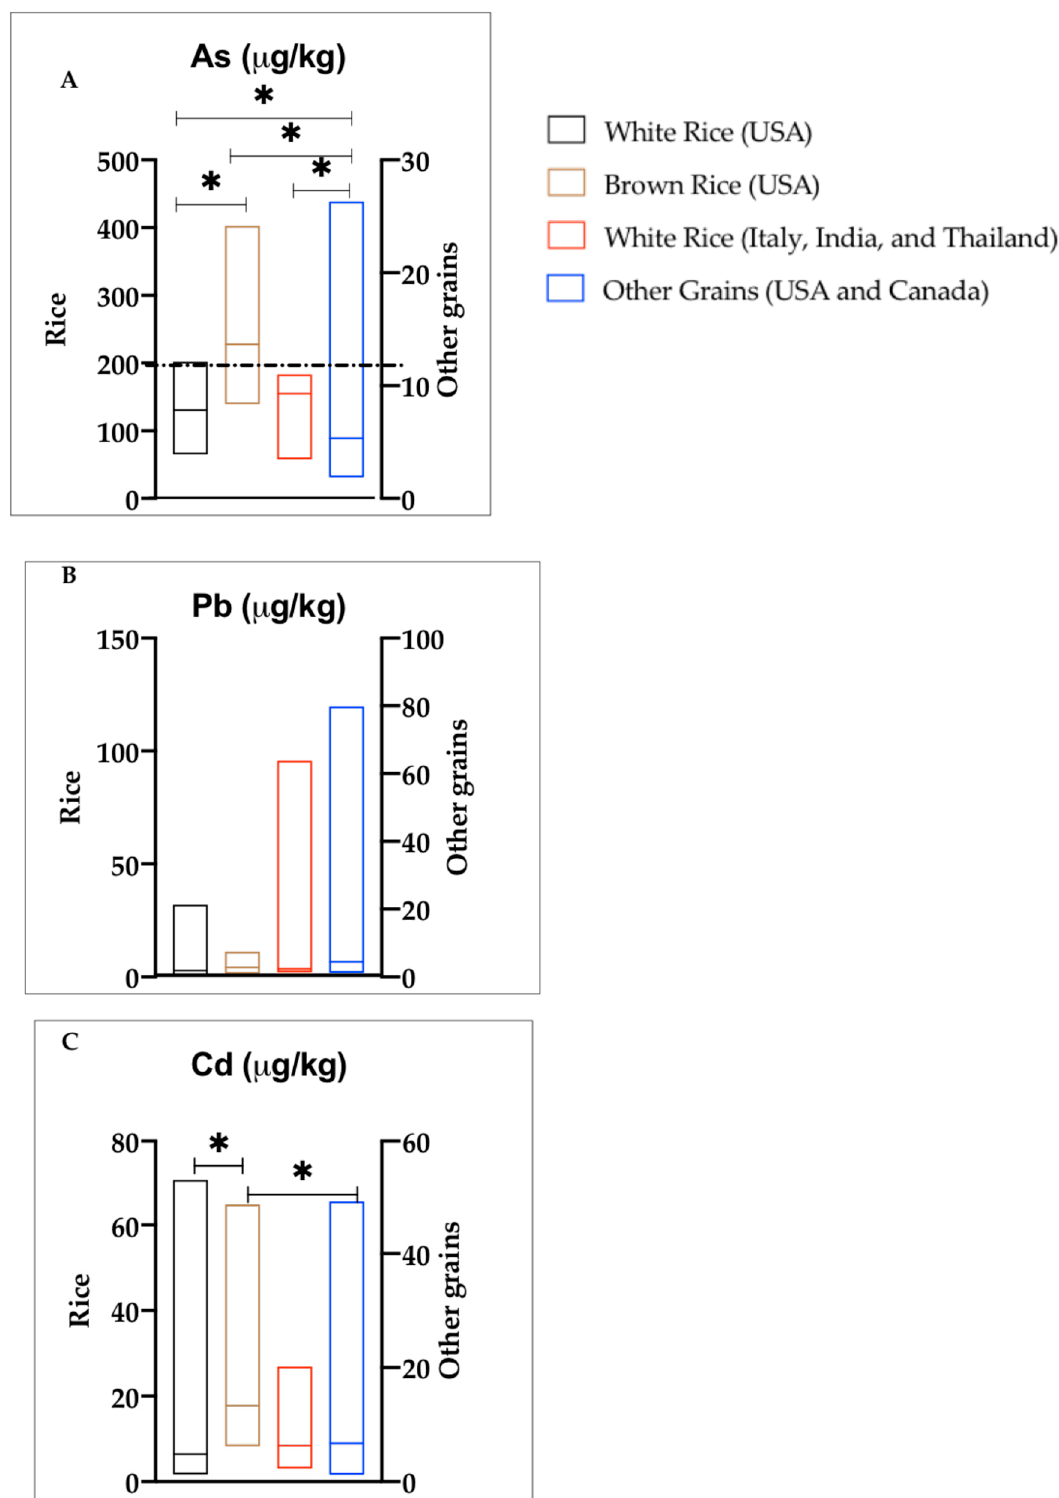
Figure 2. Toxic elements (As, Pb, and Cd) concentrations in rice and other grains (corresponding to Figure 2A, Figure 2B and Figure 2C respectively); the lines in the plots show median concentrations. Statistically significant (* p < 0.05) concentrations are based on non-parametric tests of the means. The dotted line at 200 µg/kg in figure A indicates the codex maximum limit for As in rice. Other elements were below the codex standards set for Pb (200 µg/kg in cereal grains and pulses) and Cd (100 µg/kg in cereals/pulses and 400 µg/kg in polished rice).